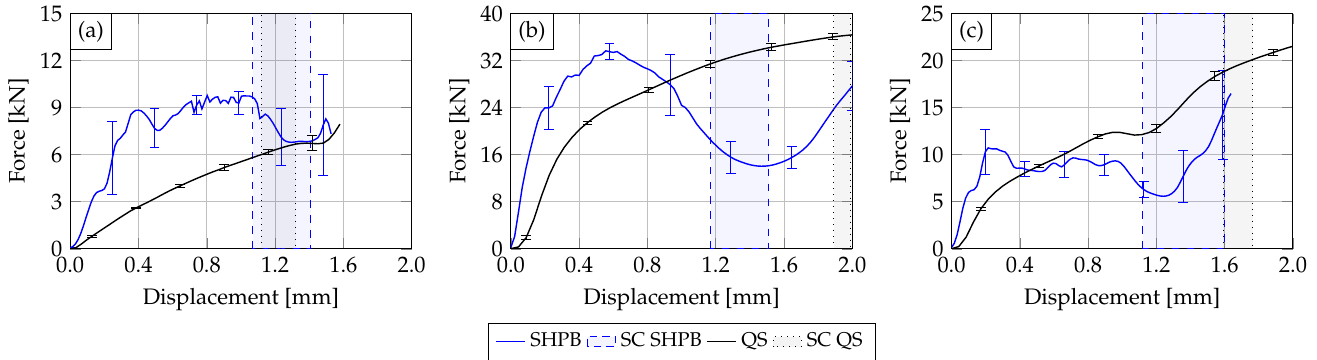
Figure 9. Comparison of the experimental results obtained from the quasi-static (solid black curve) and the dynamic characterization tests (solid blue curve) on the PA6GF30 busbars with impactor V1 ( a ), V4 ( b ) and V5 ( c ). The according electrical SR ranges are also displayed.